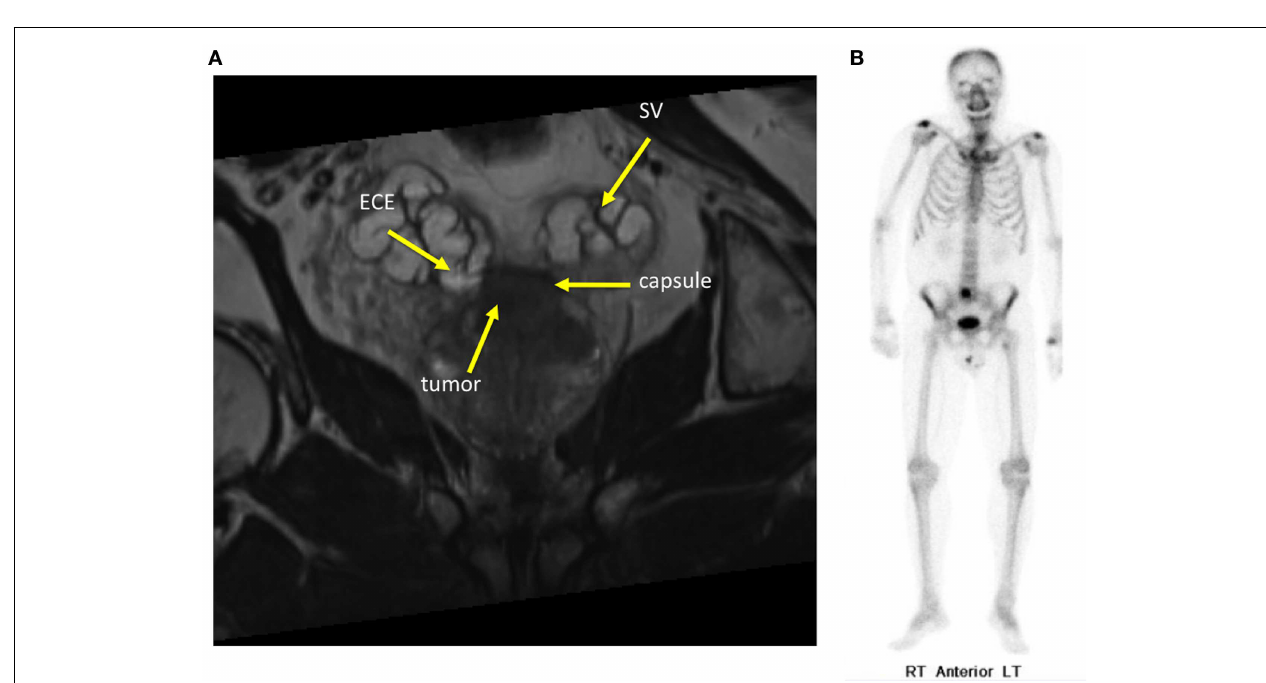
reconstruction MRI image demonstrating extracapsular extension into the seminal vesicles. (B) Bone scan demonstrating a solitary L5 vertebral body